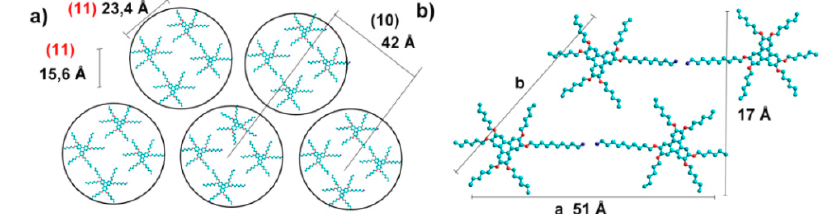
Figure 7. Proposed self-assembly for gels of triphenylene 5 in methanol ( a ) and triphenylene 6 in n -hexane ( b ). Structures: blue (carbon), red (oxygen), and violet (nitrogen).